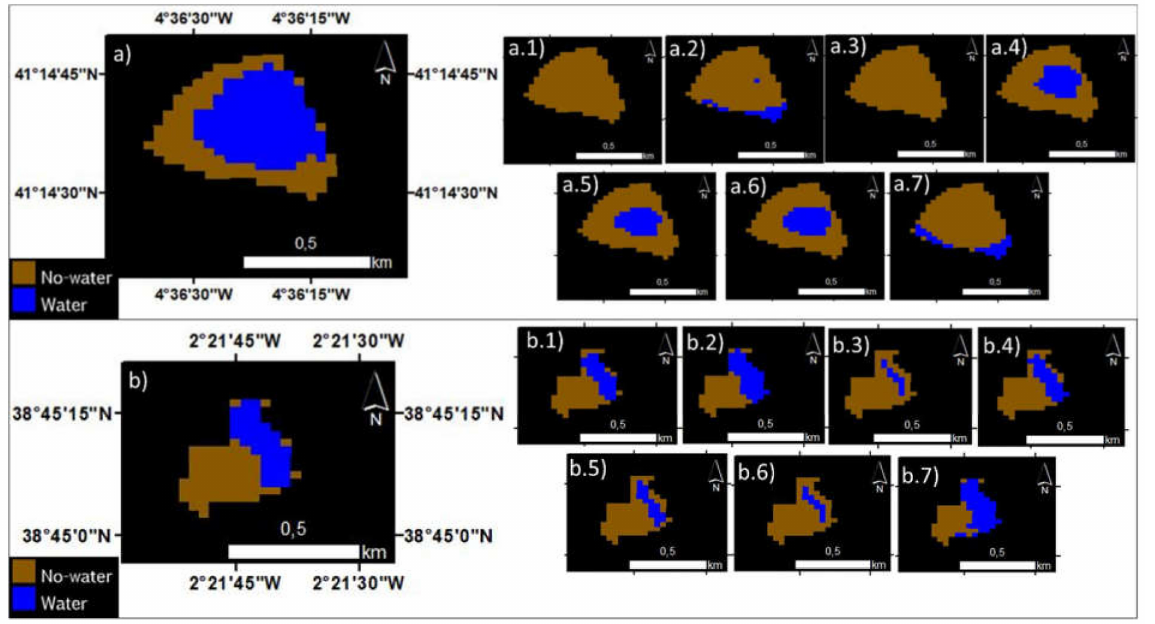
Figure 4. Results of the classification (right) using the GP0.1 ( a.1 , b.1 ), GP-0.05 ( a.2 , b.2 ), NDWI ( a.3 , b.3 ) AWEInsh ( a.4 , b.4 ), AWEIsh ( a.5 , b.5 ), WRI ( a.6 , b.6 ) and WTI ( a.7 , b.7 ) for ( a ) Laguna de Caballo Alba and ( b ) Laguna del Arquillo for the Landsat image dates of 20 June 2015 and 29 July 2017, respectively and the reference dates (left) of 19 June 2015 ( a ) and 29 July 2017 ( b ),